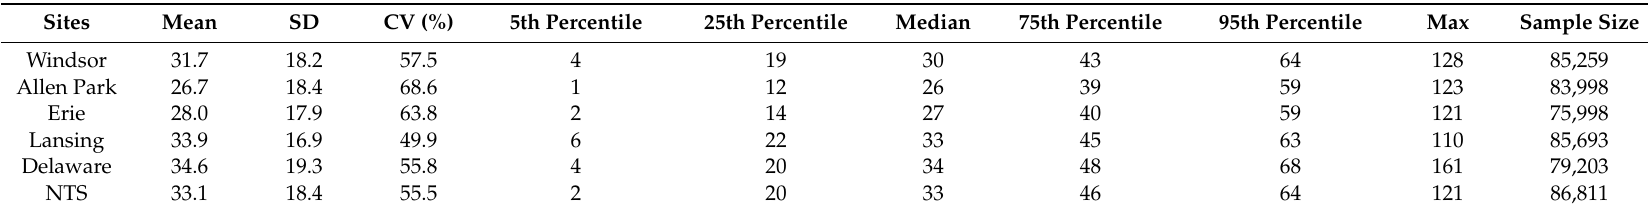
Table 2. General statistics of smog season O 3 concentrations (ppb) at Windsor and five US sites during 1996–2015. SD stands for standard deviation. CV stands for coe ffi cient of variation (SD / mean *